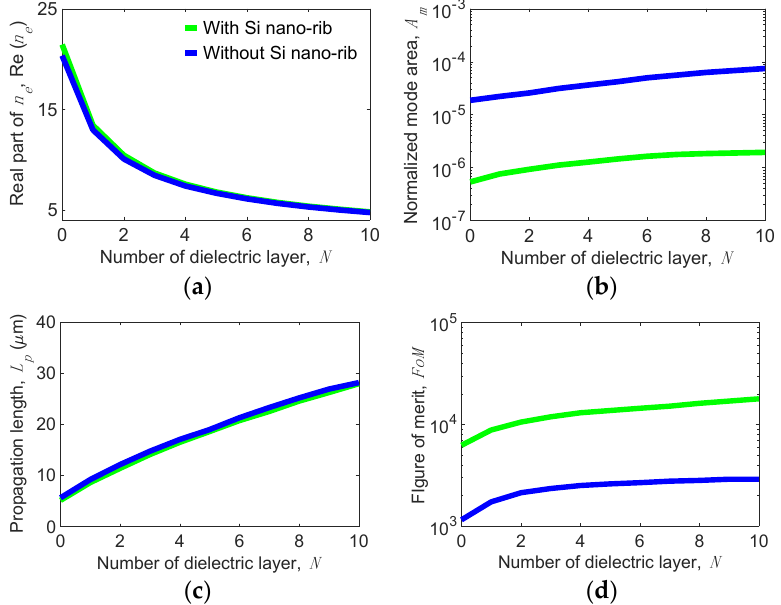
Figure 6. ( a ) Real part of effective index n e , Re( n e ), ( b ) normalized mode area, A m , ( c ) propagation length, L p , and ( d ) figure of merit, FoM versus the number of dielectric layer N for the present structure with and without the Si nano-rib.